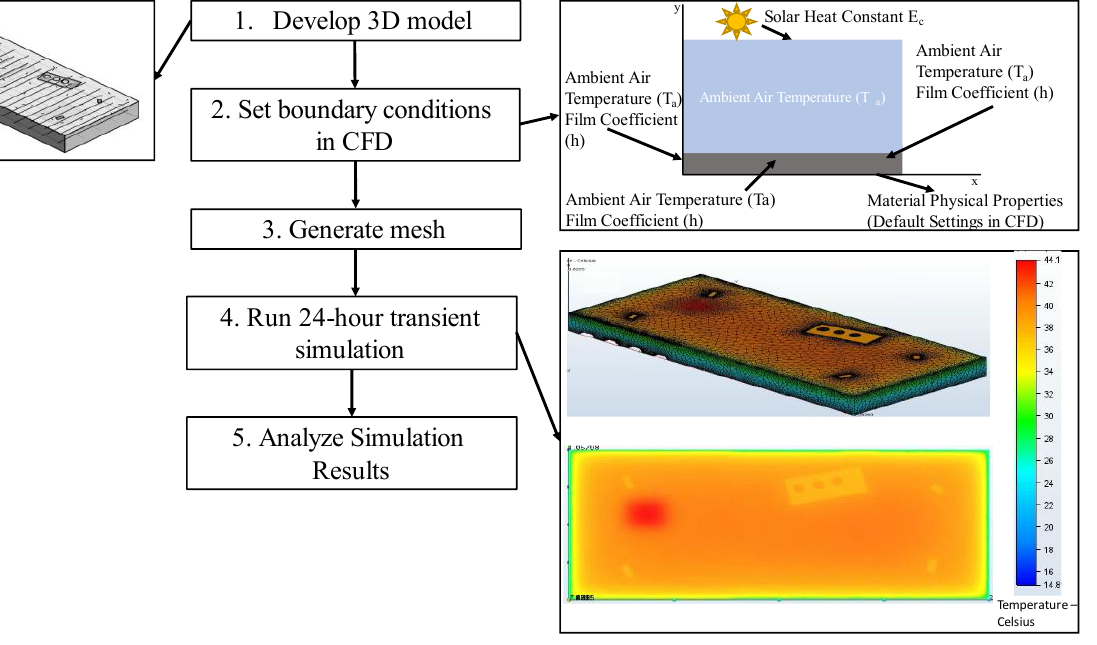
Figure 6. Numerical simulation framework. Table 5. Boundary conditions of the model.